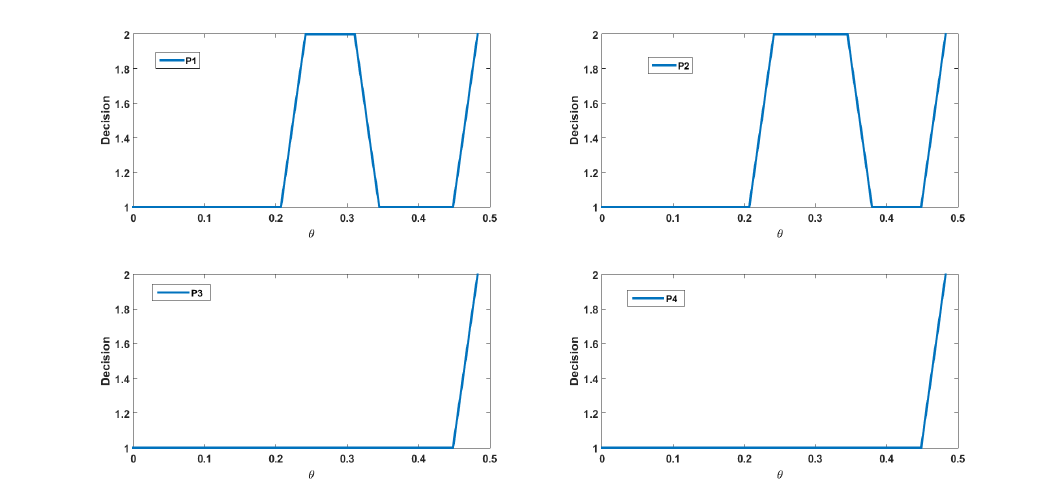
Figure 4. The optimal policy for ( x , p , θ , ρ , y ) ∈ D 0 in the plane of θ .